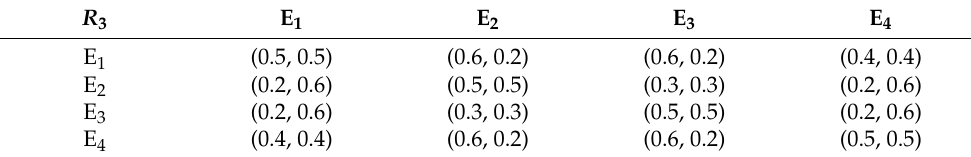
Table 12. The expert group’s intuitionistic-preference relationship for service time (C 3